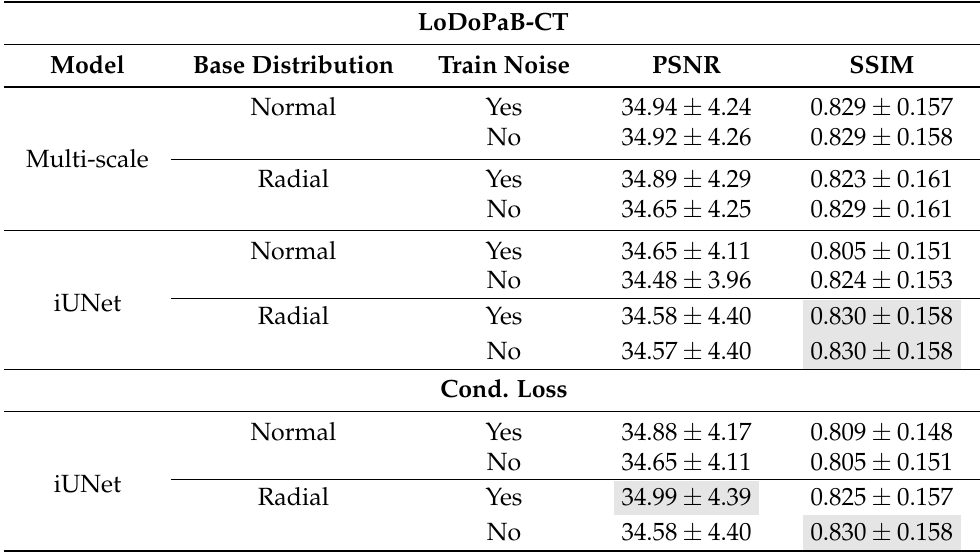
Table 3. Mean and standard deviation of the PSNR and SSIM for the LoDoPaB-CT test set. Condi- tioned mean computed with 100 samples. Unless stated otherwise, training noise was applied and no cond. loss was